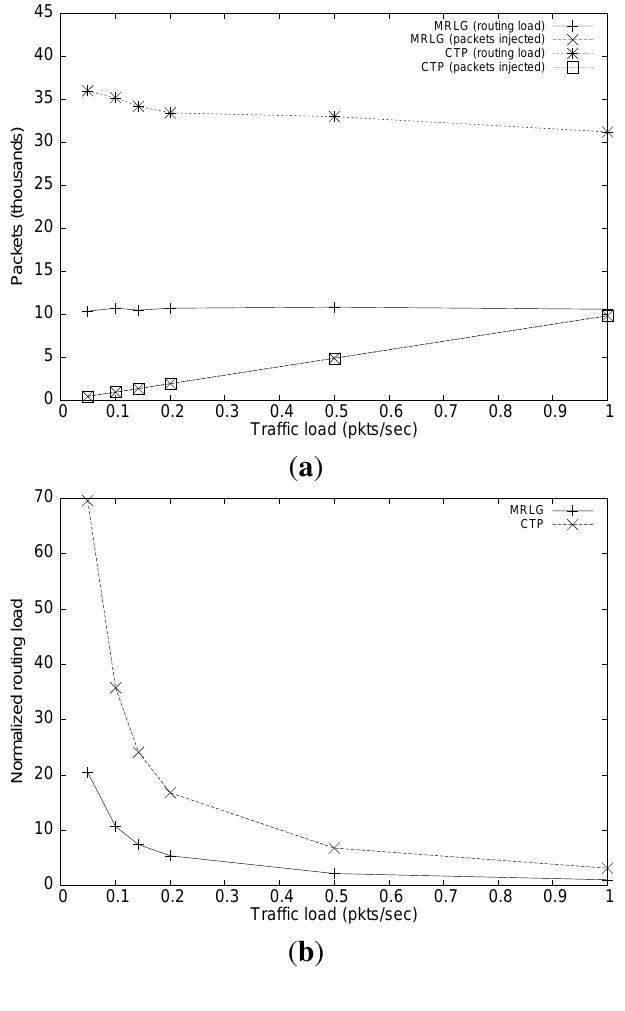
Varying the packet injection rate on a per-source